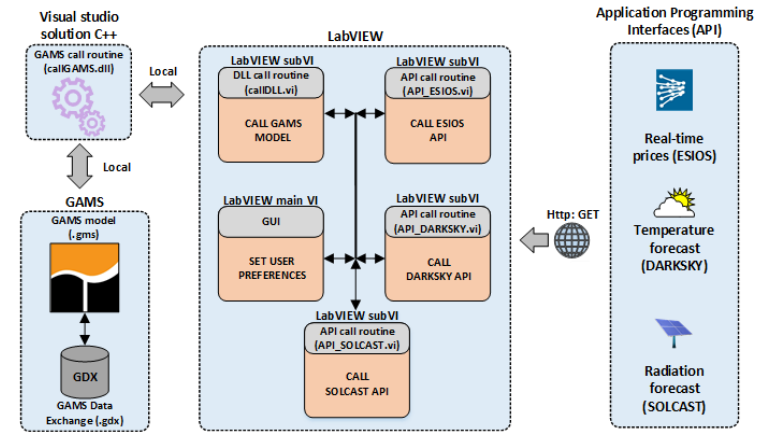
Figure 3. Block diagram of the proposed smart appliances control platform, including the GAMS (general algebraic modeling system) engine and middleware in charge of linking it to LabVIEW, the application core and Application Programming Interfaces (APIs) that provide the data.